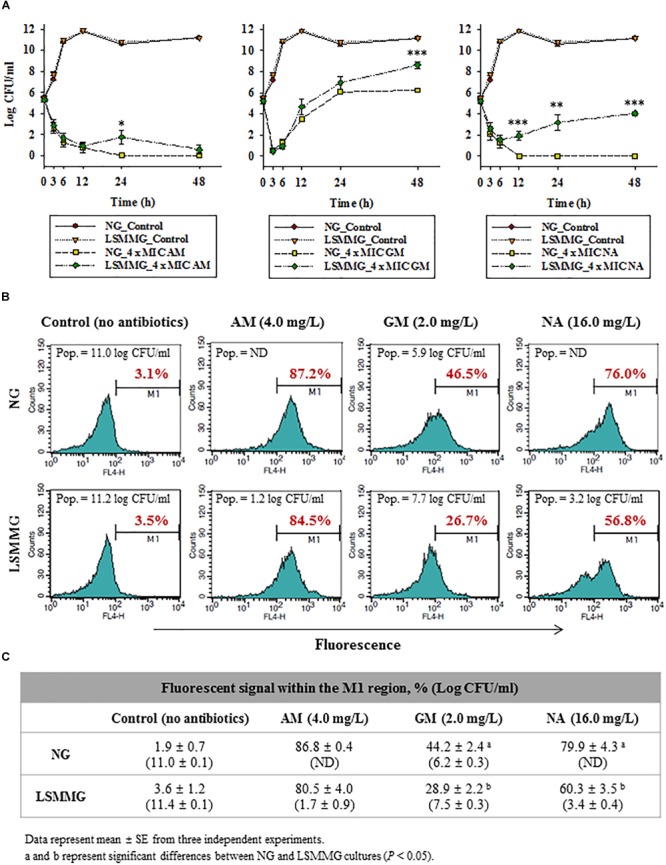
(A) Time-kill curve analysis of AM, GM, and NA under NG and LSMMG for E. coli O157 ATCC 43895 in MH broth. , growth control under NG; , growth control under LSMMG; , antibiotics at 1/2 × MIC under NG; , antibiotics at 1/2 × MIC under LSMMG; , antibiotics at 4 × MIC under NG; , antibiotics at 4 × MIC under LSMMG. The data are presented as the mean ± standard error (SE) from six independent experiments. The asterisks represent significant differences between NG and LSMMG cultures (∗P < 0.05, ∗∗P < 0.01, and ∗∗∗P < 0.001). (B,C) Flow cytometry analysis of E. coli O157:H7 ATCC 43895 treated, or not, with 4 × MIC of AM, GM, and NA under NG and LSMMG, for 24 h in MH broth: (B) histogram of fluorescent signal and (C) average fluorescent signal within the M1 region (%).